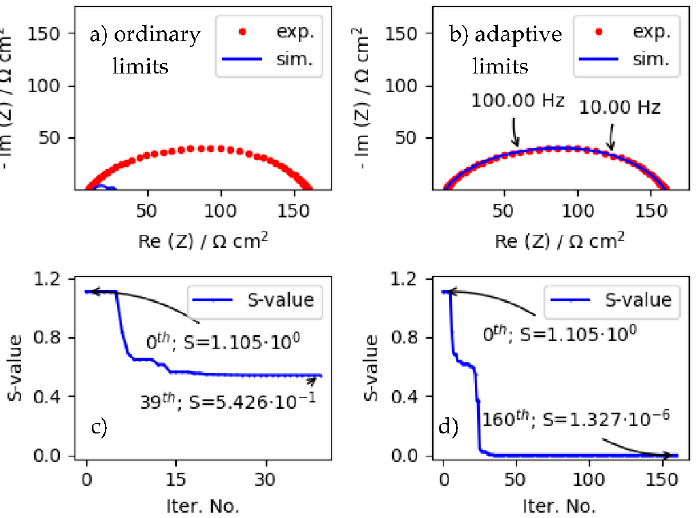
Figure 4. The impedance spectra of the corrupted ZARC data (subplots a , b ) and the corresponding S -value data (subplots c , d ). EEC R(QR)(QR)(QR) (Figure 1) was used in the fitting attempts.